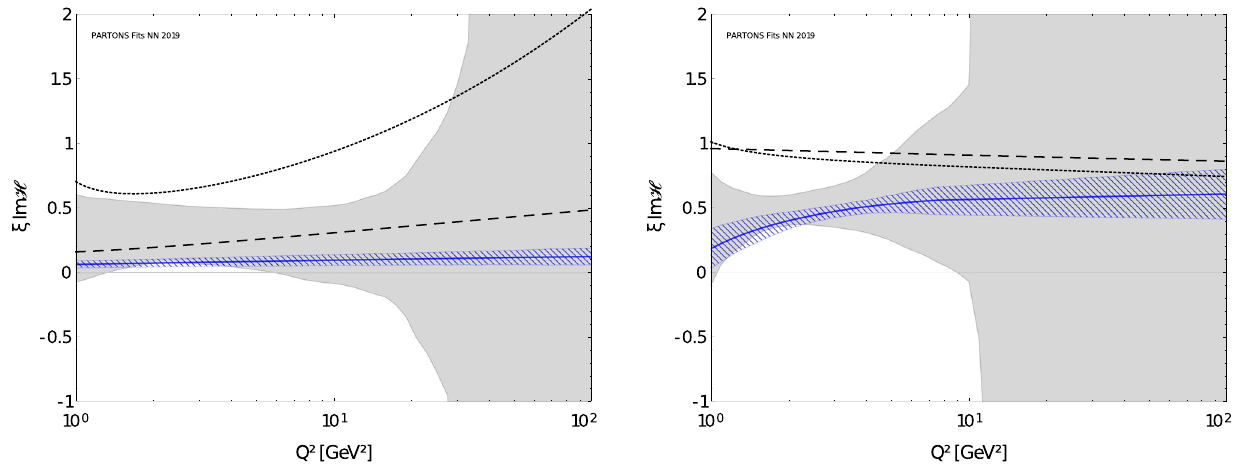
Fig. 21 Imaginary part of the CFF H as a function of Q 2 for t = − 0 . 3 GeV 2 and ξ = 0 . 002 (left) and ξ = 0 . 2 (right). For further description see